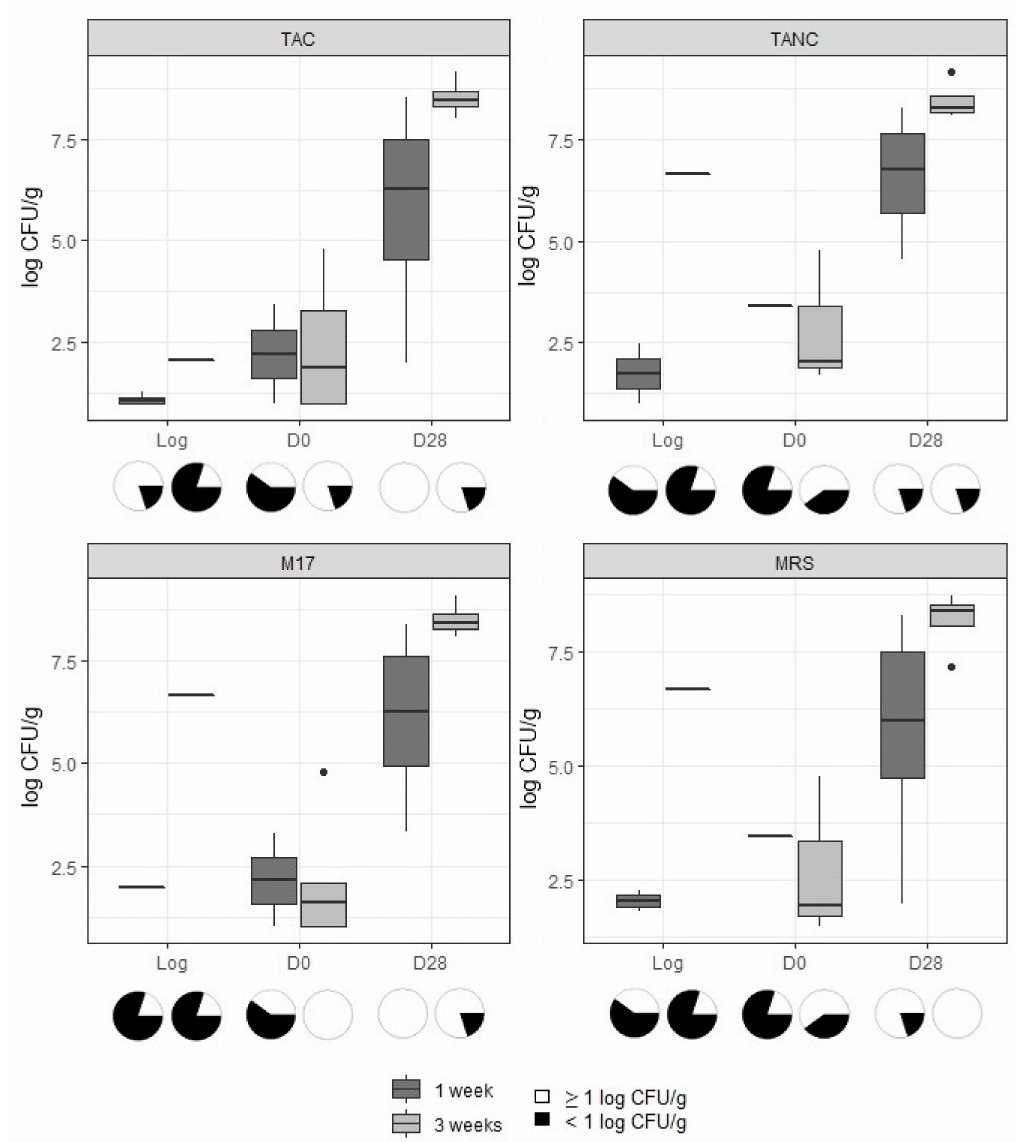
Figure 3. Log(CFU/g) values for total psychrotolerant and psychrophilic aerobic (TAC) and anaerobic counts (TANC) and lactic acid bacteria counts (M17 and MRS agar) found on cooked chicken samples. The boxplots represent the 1st quartile, median, 3rd quartile and, if applicable, outliers of each dataset. Each boxplot contains five data points, except for when a sample was below the enumeration limit of 1 log CFU/g. In these cases, n will deviate. Deviation in data points is visualized by pie charts: white representing the countable samples and black representing the samples below the enumeration